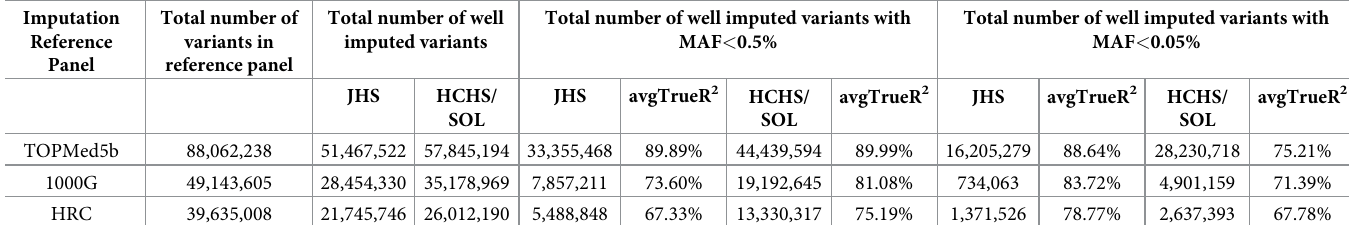
Table 1. Number of well-imputed variants using TOPMed freeze 5b, 1000 Genomes Phase 3 (1000G) and Haplotype Reference Consortium (HRC).